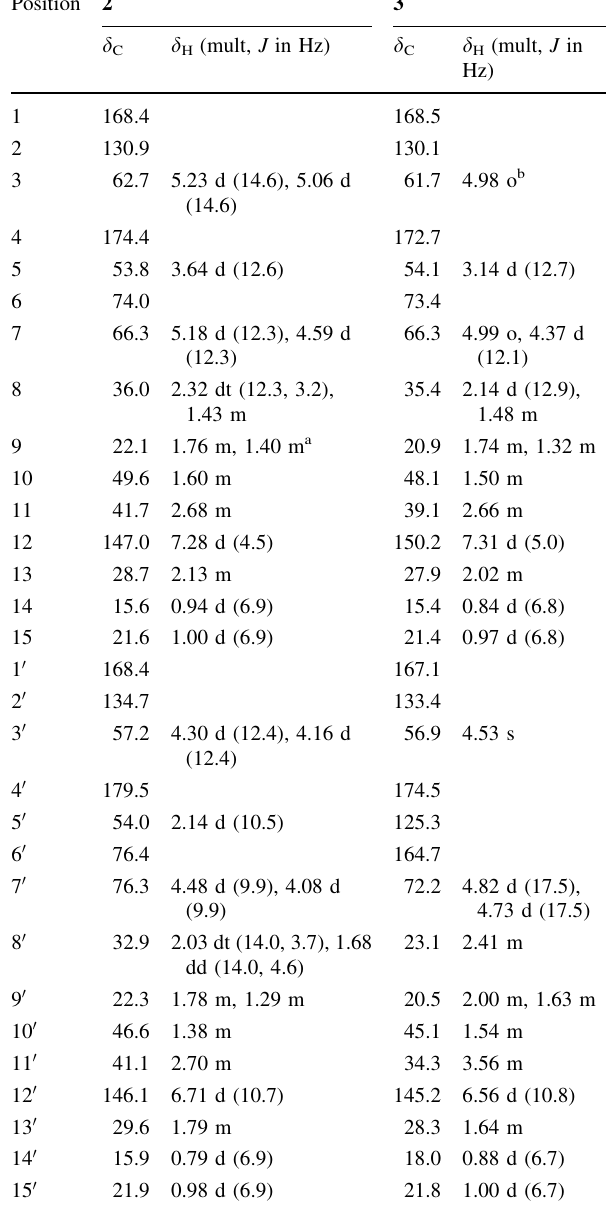
Table 2 1 H NMR and 13 C NMR spectroscopic data of compounds 2 and